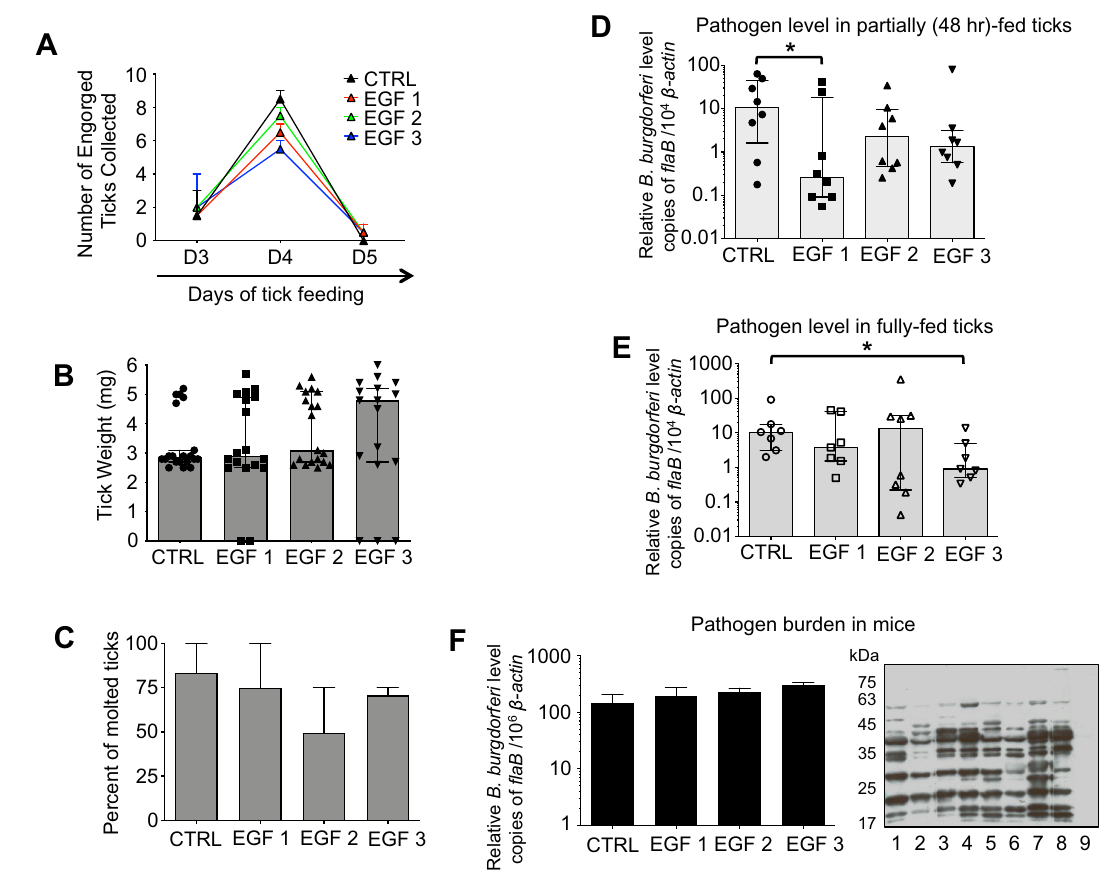
Figure 5. EGF immunization affects B. burgdorferi acquisition. Mice were immunized with Is86 EGF-1, -2, or -3, infected with B. burgdorferi , and then parasitized by naïve ticks. Ticks that fed on mice immunized with adjuvant only were used as controls. ( A ) Mean number of replete ticks, with error bars showing ± SEM. Fully replete ticks were collected and counted (n = 20, 17, 20, 16 ticks/group of 2 mice, respectively). ( B ) Median tick engorgement weight. The weights of fully replete ticks (n = 20, 18, 19, 17 ticks/group, respectively) were measured with error bars showing 95% confidence intervals (CI). Data points with zero values indicate unattached live or dead ticks collected 24 h post infestation. ( C ) Mean tick molting rate, with error bars showing ± SEM. The collected ticks were allowed to molt (n = 6, 7, 8, 7 ticks/group of 2 mice, respectively) in the incubator, and the percentage of molted ticks was calculated. Median B. burgdorferi burdens in ( D ) 48-h fed ticks and ( E ) fully replete ticks (n = 8, 7 ticks/group, respectively), with error bars showing 95% CI. Spirochete burdens in ticks were assessed by measuring copies of flaB using qPCR and normalizing against tick β-actin. ( F ) Mean B. burgdorferi burden in mouse skin (n = 2), with error bars showing ± SEM. This experiment represents the acquisition of spirochetes from infected mice to naïve ticks. Murine skin samples were collected after the completion of tick feeding. Spirochete levels were evaluated by measuring copies of flaB using qPCR and normalizing against mouse β-actin . The right-side panel shows a Western blot of B. burgdorferi lysates, which were probed with B. burgdorferi -infected mouse sera (control groups in lanes 1 and 2, EGF-1-immunized in lanes 3 and 4, EGF-2-immunized in lanes 5 and 6, EGF-3-immunized in lanes 7 and 8, and normal mouse serum in lane 9). The asterisks in the graphs indicate statistically significant differences at p <